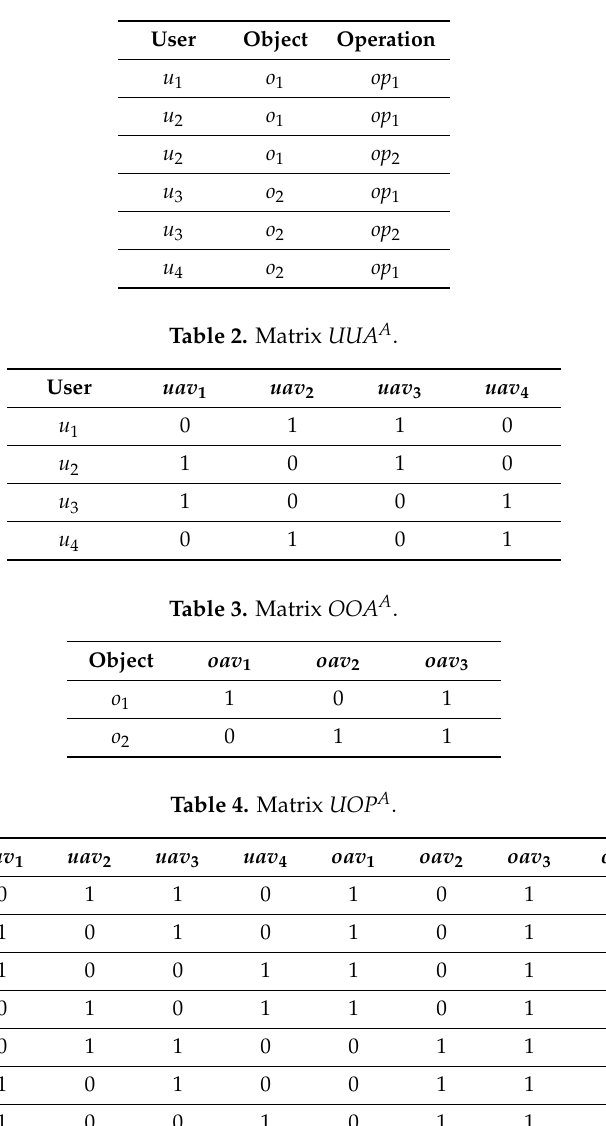
Table 1. Authorization list A .